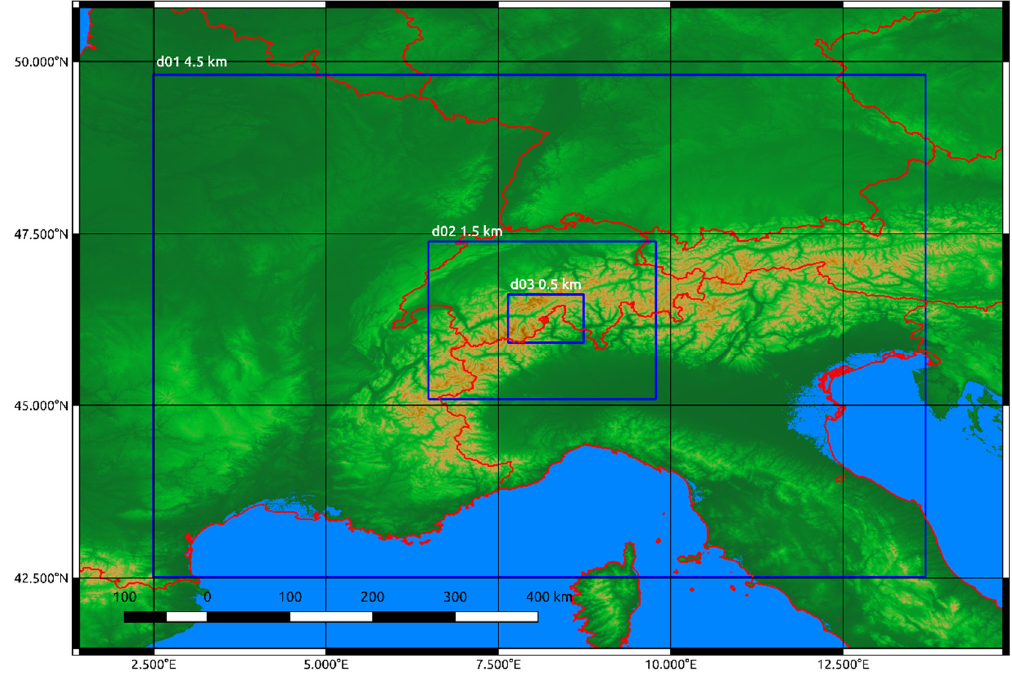
Figure 4. The WRF simulation domains (in blue) with the topography from NASA SRTM DEM used for the WRF preprocessing system.